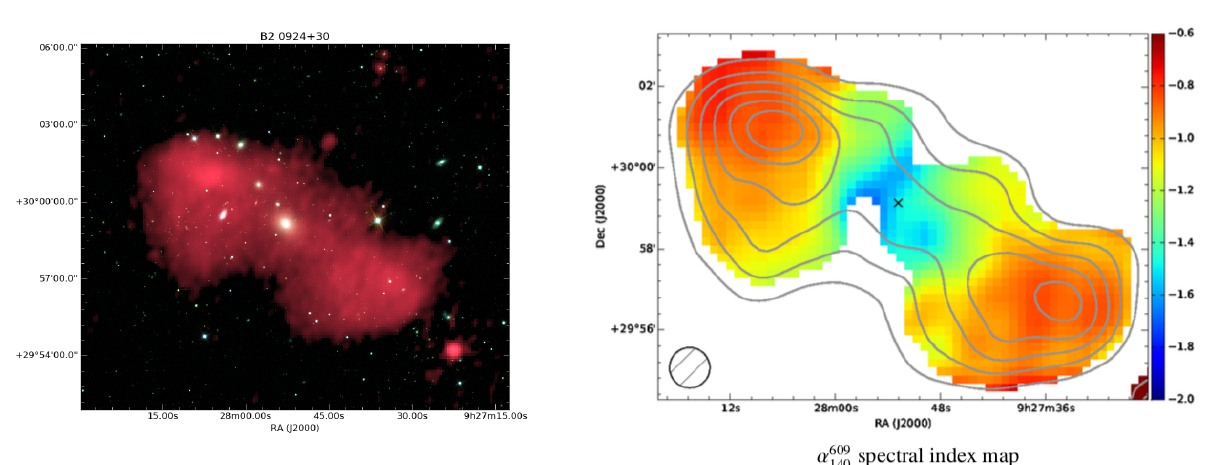
Figure 1. Left: total intensity (red) of B2 0924+30 showing the diffuse, amorphous, and low-surface brightness structure superposed to an optical image (the galaxies are shown in white, background in black). Right: the spectral index between 140 and 609 MHz, showing that flatter spectral indices are found towards the outer edges of the lobes, Ref. [30]. Figures taken from